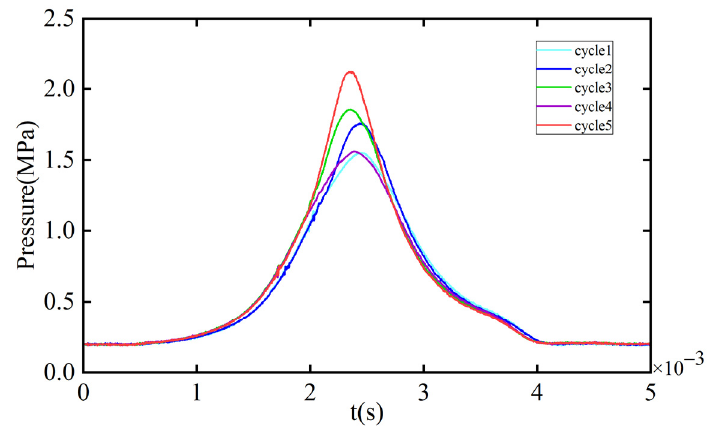
Figure 3. Cylinder combustion pressure for di ff erent cycles.